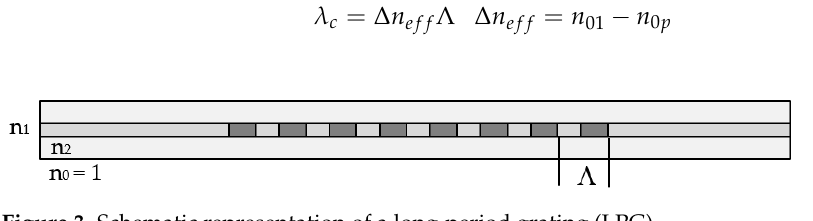
Figure 3. Schematic representation of a long-period grating (LPG).